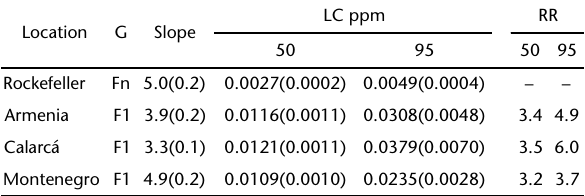
Table I. Temephos susceptibility profile from Colombian populations of Aedes aegypti , showing means (standard deviations) for slopes, LC and